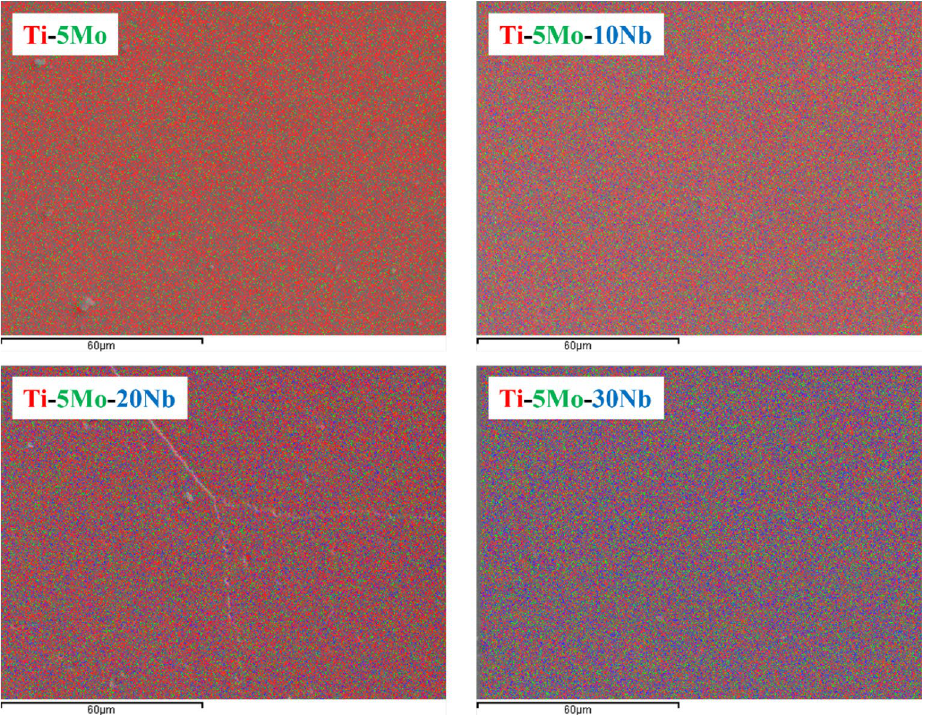
Figure 2. Chemical mapping of the elements Ti (red), Mo (green), and Nb (blue) of the as-cast Ti-5Mo-Nb system alloys by EDS.